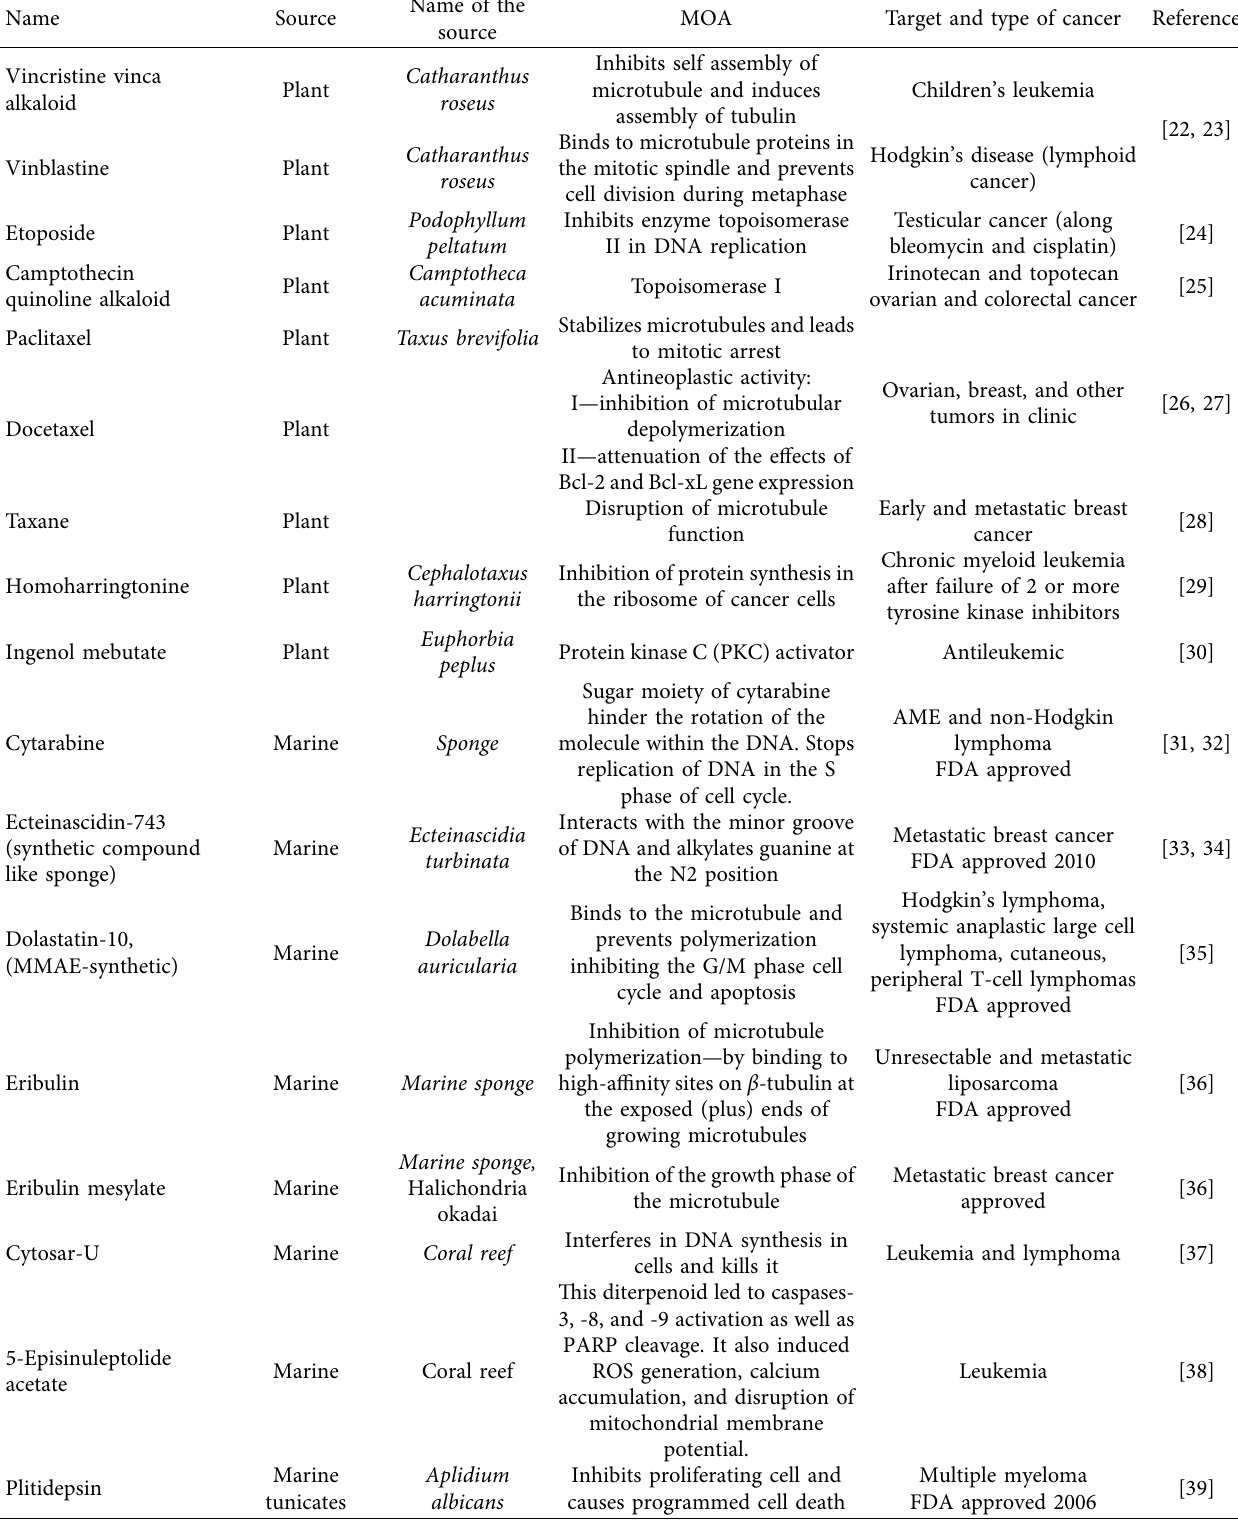
Table 1: Anticancer agent from natural source that has been already used in the treatment of various cancers in humans and FDA-approved